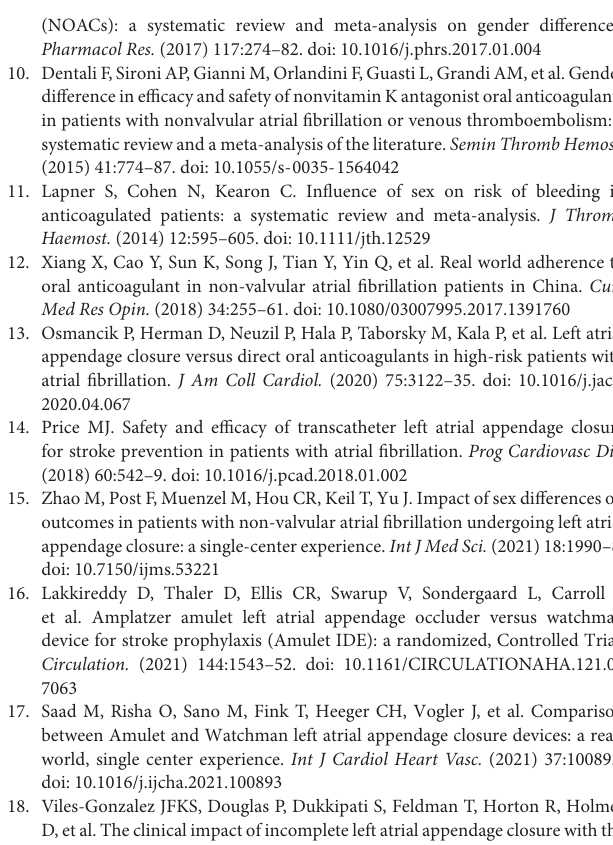
Supplementary Figure 1 | Rates of free from cardiovascular or unexplained death, ischemic stroke, fatal or disabling ischemic stroke, major bleeding, MACE, and fatal or disabling MACE between Watchman and ACP. Kaplan–Meier curves of cardiovascular or unexplained death (A) , ischemic stroke (B) , fatal or disabling ischemic stroke (C) , major bleeding (D) , MACE (E) , and fatal or disabling MACE (F) according to Watchman and ACP. MACE, major adverse cardiovascular events, including cardiovascular or unexplained death, ischemic stroke or major bleeding; LAAC, left atrial appendage closure; ACP, Amplatzer Cardiac Plug; HR, hazard ratio; CI, confidence